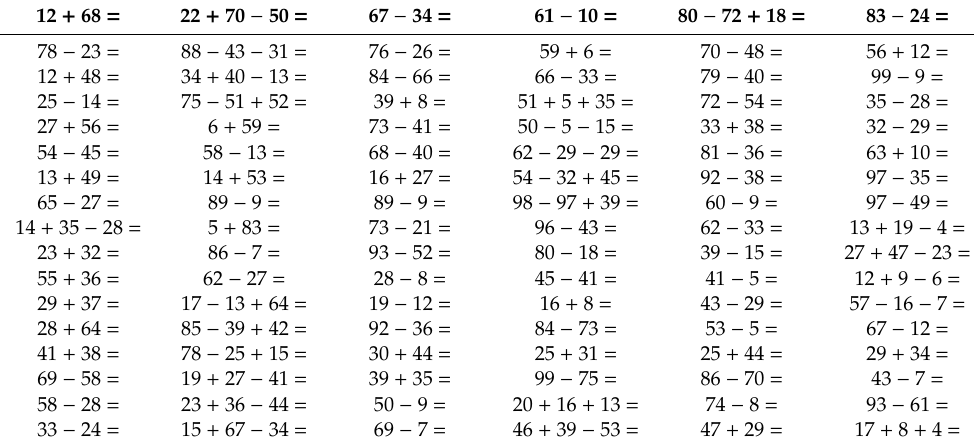
Table A1. Answer the following 100 arithmetic questions in 2 min.